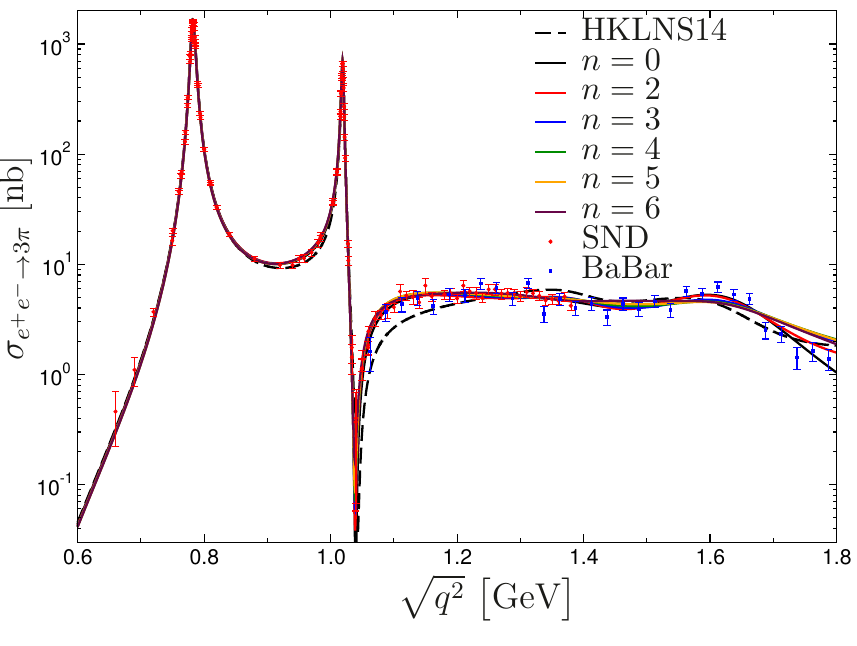
Figure 6. Fits to the e + e (cid:0) 3 (cid:25) cross section from SND [130, 131] and BaBar [132] with ! the di(cid:11)erent variants of the conformal polynomial labeled by n , the phase shift from [113], and (cid:3) 3 (cid:25) = 2 : 5 GeV, in comparison to [62]